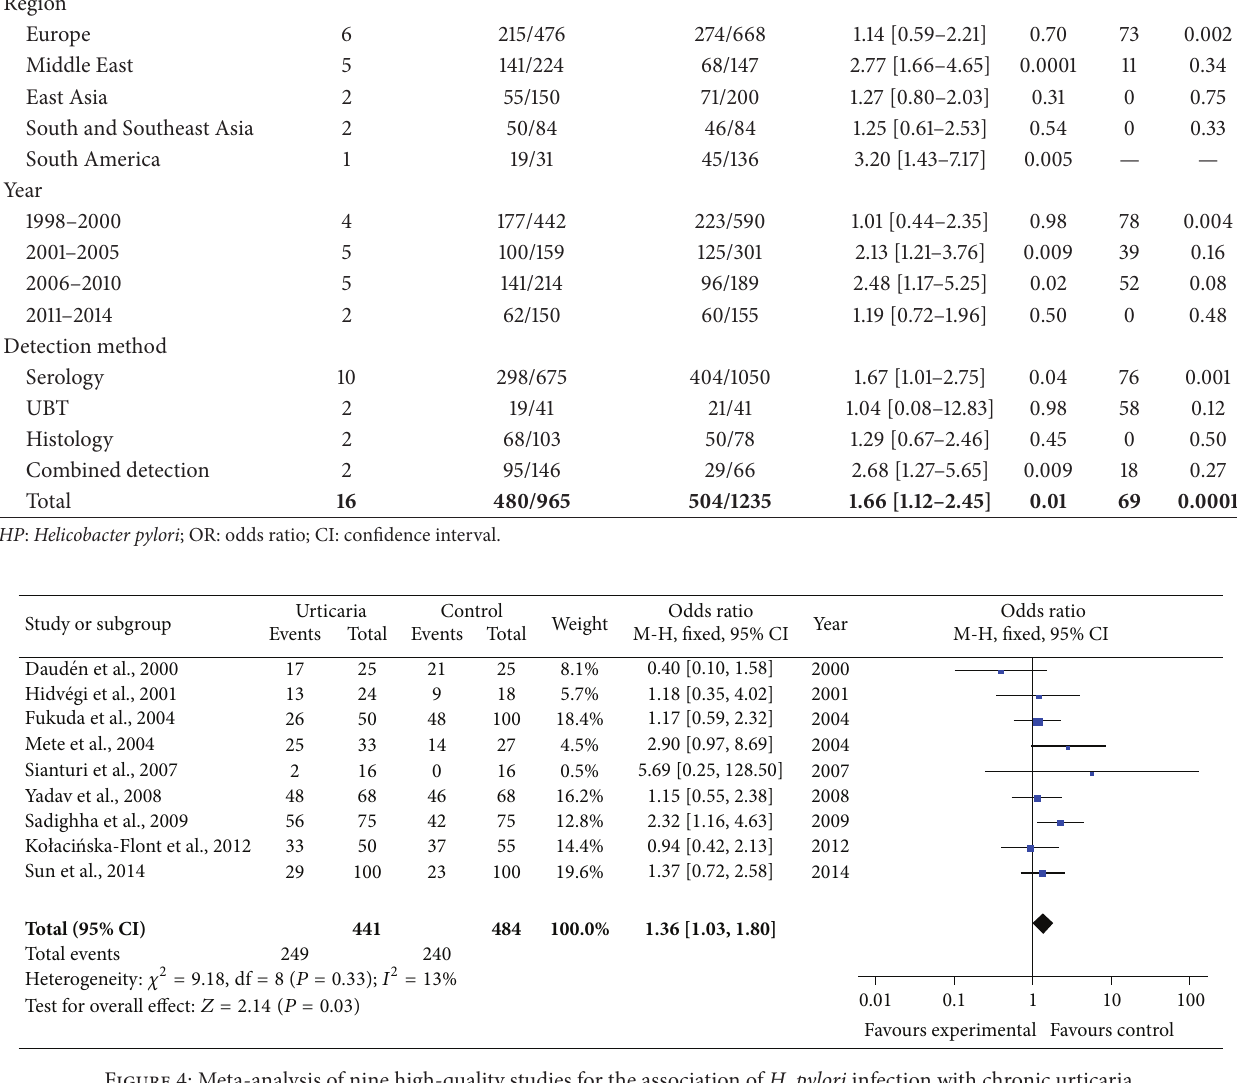
Figure 4: Meta-analysis of nine high-quality studies for the association of H. pylori infection with chronic